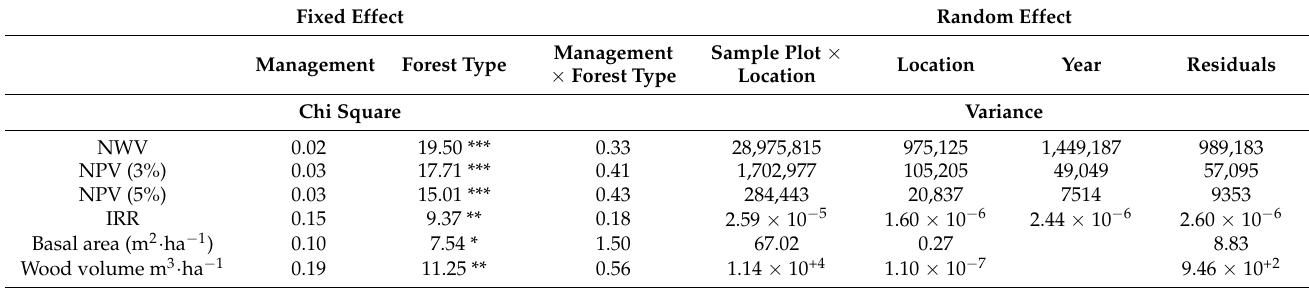
Table 2. The effect (Chi square) of management, forest type and their interaction on economic performance and stand productivity, and the variances of random effect. The asterisks denote statistical significance ( p -values) of the effects: * < 0.05, ** < 0.01, and *** < 0.001.